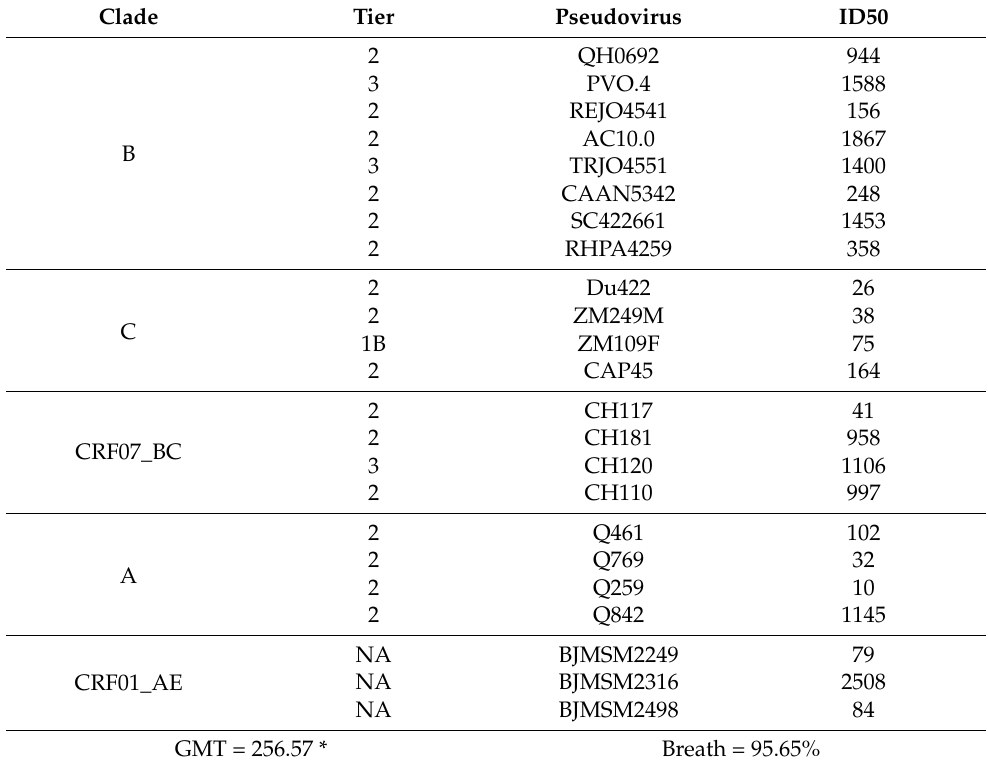
Table 2. Neutralization activities of CBJC515 plasma against DRVI (Division of Research on Virology and Immunology) panel pseudoviruses ( n = 23). Clade Tier Pseudovirus ID50 2 QH0692 944 3 PVO.4 B